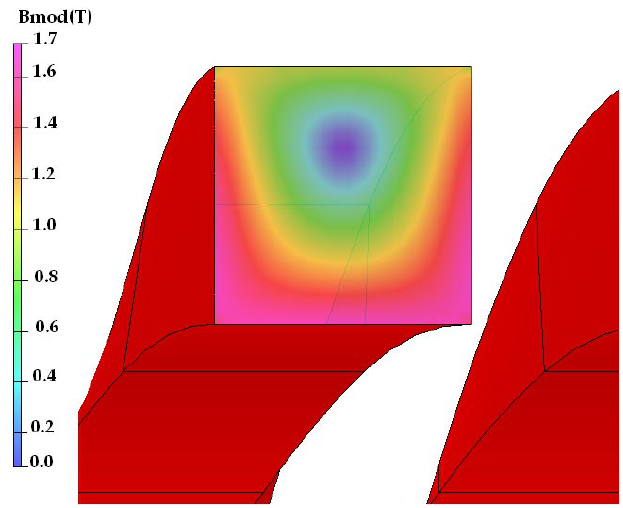
FIG. 7. (Color) Calculated magnetic flux density (Bmod) through a cross section of the conductor windings for a current density of 1000 A mm (cid:2) 2 . The highest flux is in pink near the axis of the magnet and is 1.75 T. The lowest flux is in blue near the center of the winding and is 77 mT.